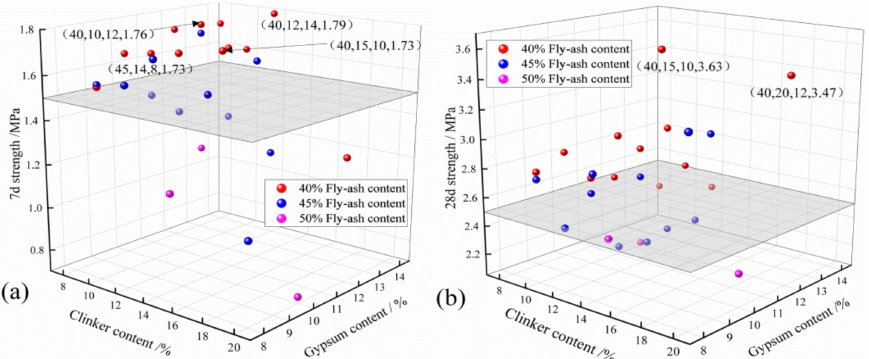
Figure 1. Composite cementitious material filling body strength test result: ( a ) 7 d, ( b ) 28 d.